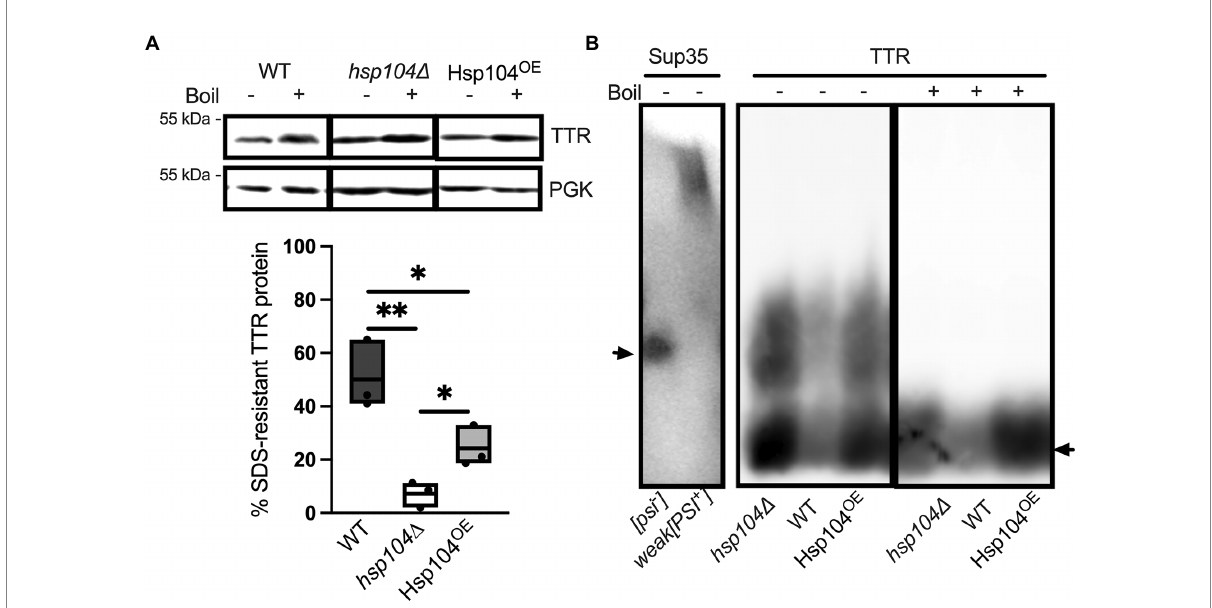
FIGURE 2 Hsp104 enhances the formation of SDS-resistant populations, but oligomer size appears to be unaffected (A) (Top) Lysates from WT or hsp104 ∆ strains co-transformed with TTR-GFP and HSE-EV, or hsp104 ∆ strains co-transformed with TTR-GFP and HSE-Hsp104 (Hsp104 OE ) were incubated at room temperature ( − ) or boiled (+). Representative Western blots using anti-TTR or anti-PGK antibody, captured with different detection methods (see Materials and Methods), is shown. PGK was used to confirm even sample loading and quantification of the amount of SDS-resistant aggregated protein was determined by calculating the ratio of unboiled to boiled sample (Bottom). Quantification is from 3 Independent trials. Data is shown as means and ranges. * p ≤ 0.05, ** p ≤ 0.01, by unpaired two-tailed t -test. (B) SDD-AGE analysis was used to resolve SDS-resistant oligomers. Lysates from [ psi − ] or weak[ PSI + ] strains (left) or TTR expressing lysates from the indicated (right) were subjected to SDD-AGE analysis and visualized with anti-Sup35 and anti-TTR, respectively. Arrows denote monomeric Sup35 (Left) or TTR-GFP (right). It is important to note that lysates from strains are loaded in a different order than (A) . Representative images are